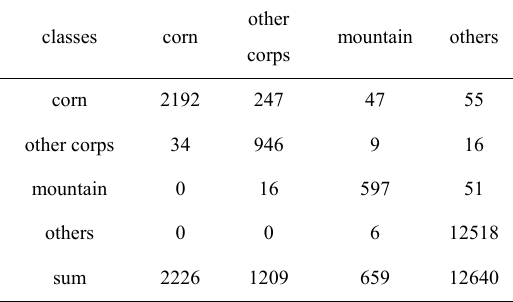
Table 3. Classification by combining TM and